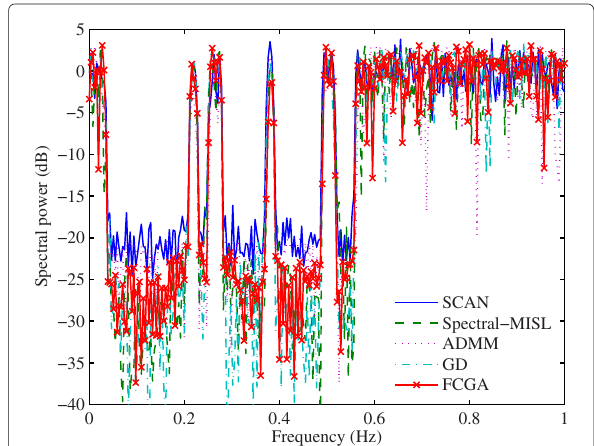
Fig. 9 Spectral power of sequences generated by five different